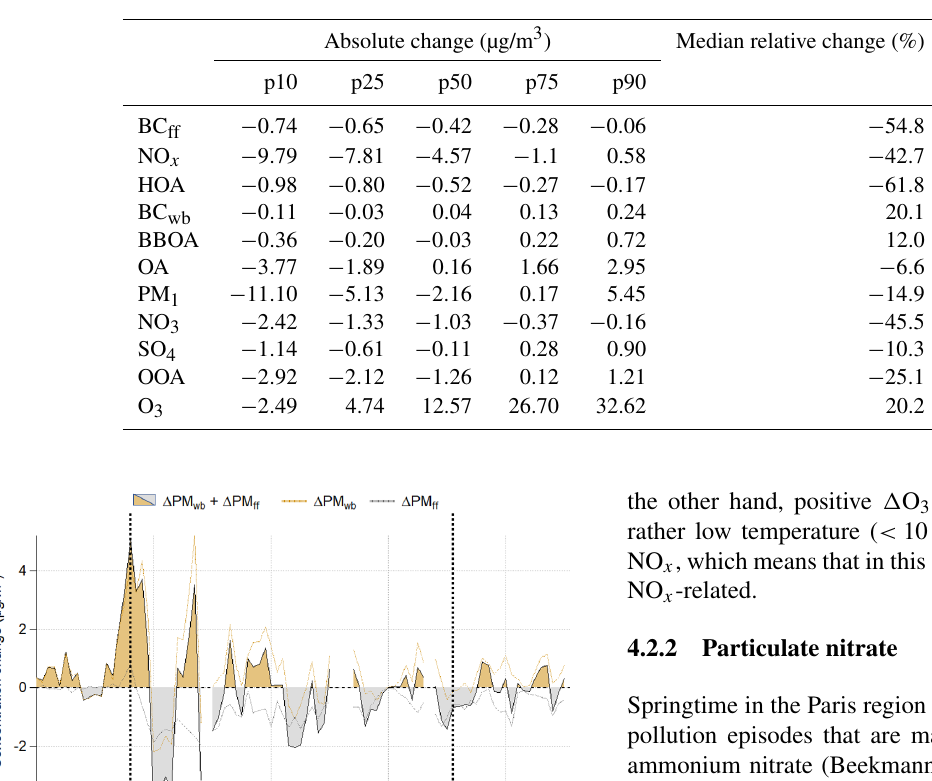
Table 5. Distribution of absolute concentration change (10th, 25th, 50th, 75th and 90th percentile were used), as well as the median relative change (%). The p values (95% confidence interval) of the pairing Student t test between observations and analog time series during lockdown.